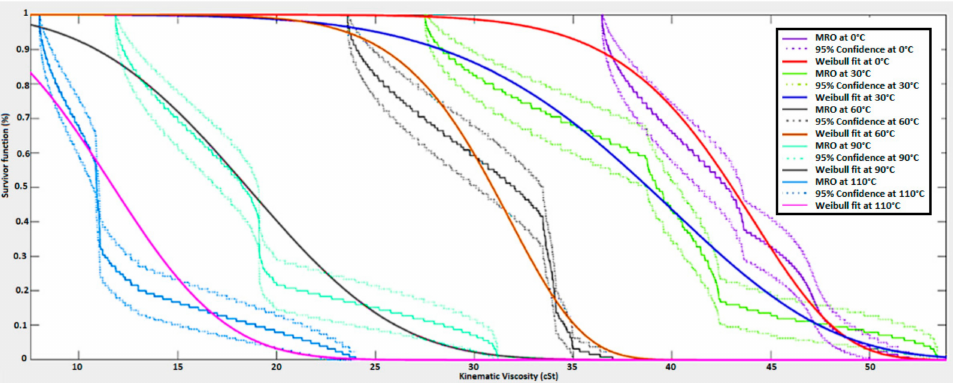
Figure 19. Kinematic viscosity survival function of MRO showing the confidence of 95% fitted to the Weibull. The nanoparticle concentration effect on kinematic viscosity reverses after 0.75 g/L